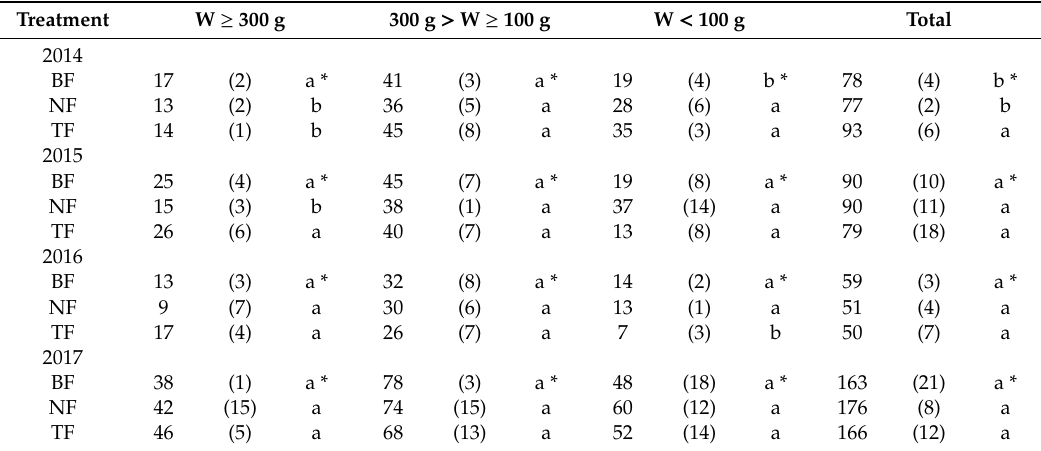
W: Weight per tuber. Values of standard deviations were in parentheses. * Values in a column with di ff erent letters were statistically di ff erent by Duncan’s multiple range test ( p < 0.05). Values in a column with the same letter were statistically similar by Duncan’s multiple range test ( p > 0.05).